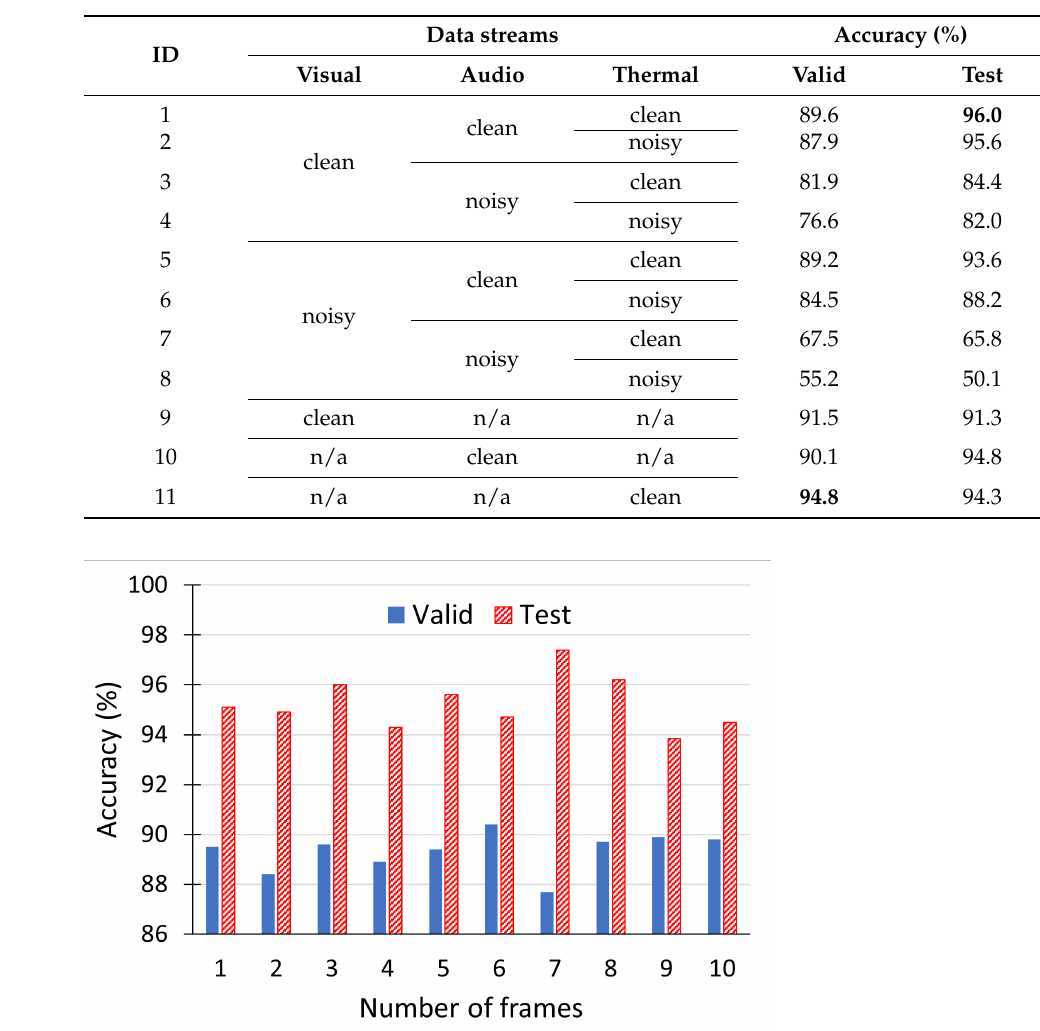
Figure 8. The impact of increasing the number of visual and thermal frames on the multimodal gender classification accuracy, when all streams are